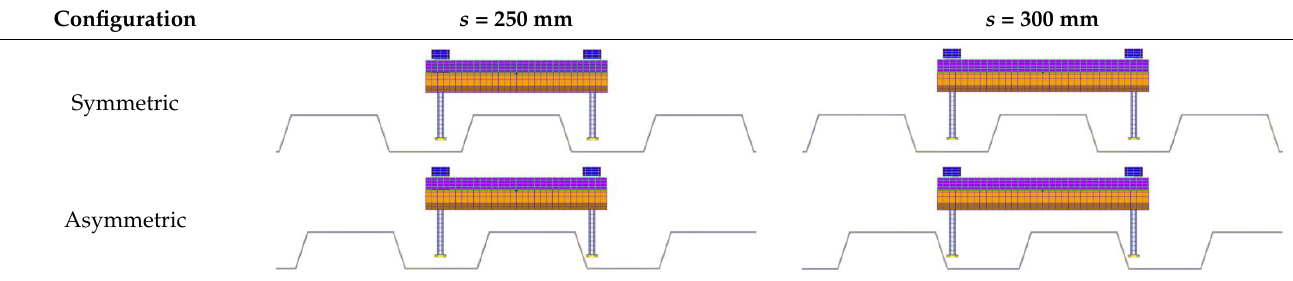
Table 6. Investigated configurations in Series 3 for the trapezoidal profile.